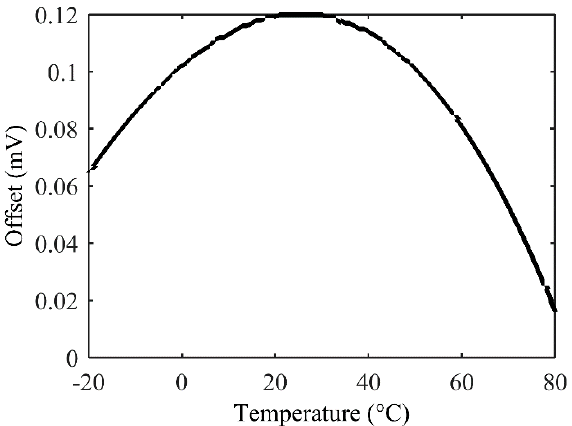
Figure 7. Typical TDO after offset compensation with the improved architecture.